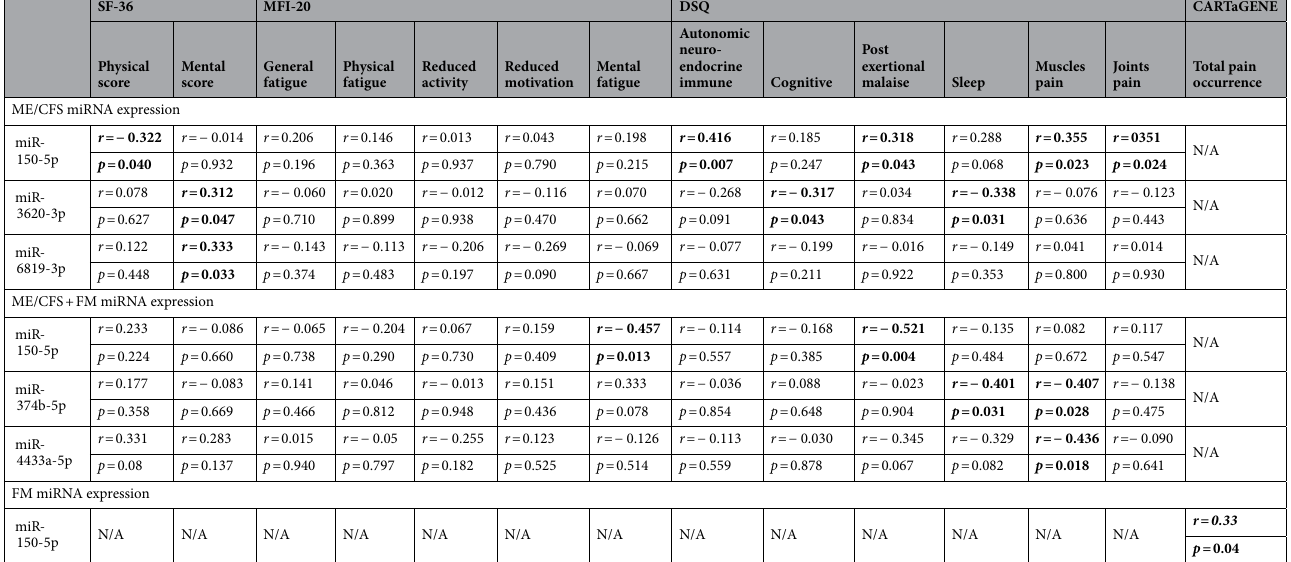
Table 4. Correlation between 11 miRNAs and different symptoms in ME/CFS, ME/CFS + FM and FM groups. Pearson’s correlation coefficient (r) and the P-value are presented. P values < 0.05 were considered significant and are indicated in